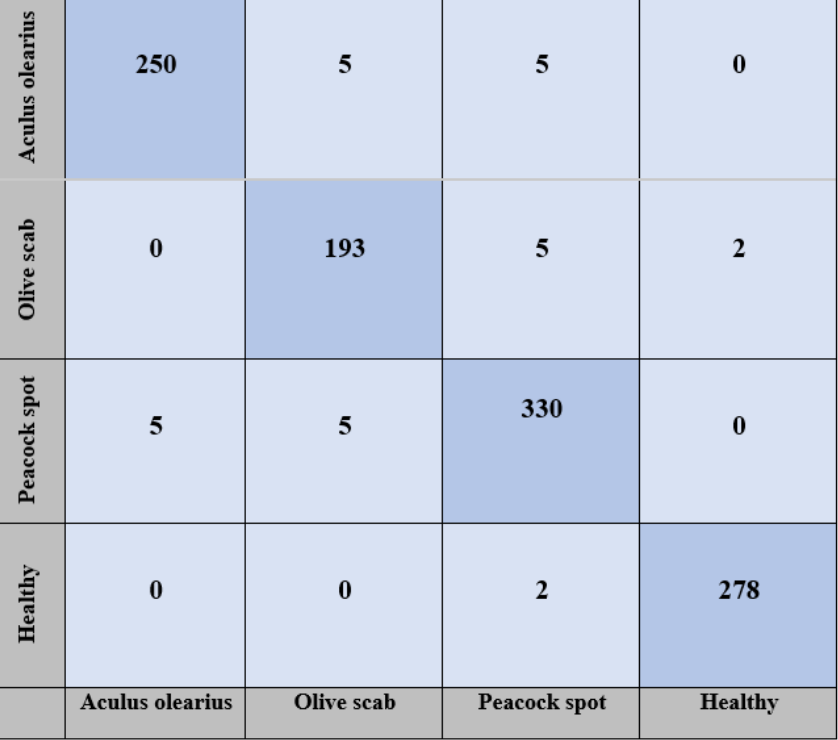
Figure 13. Confusion matrix of the proposed MobiRes-Net model.